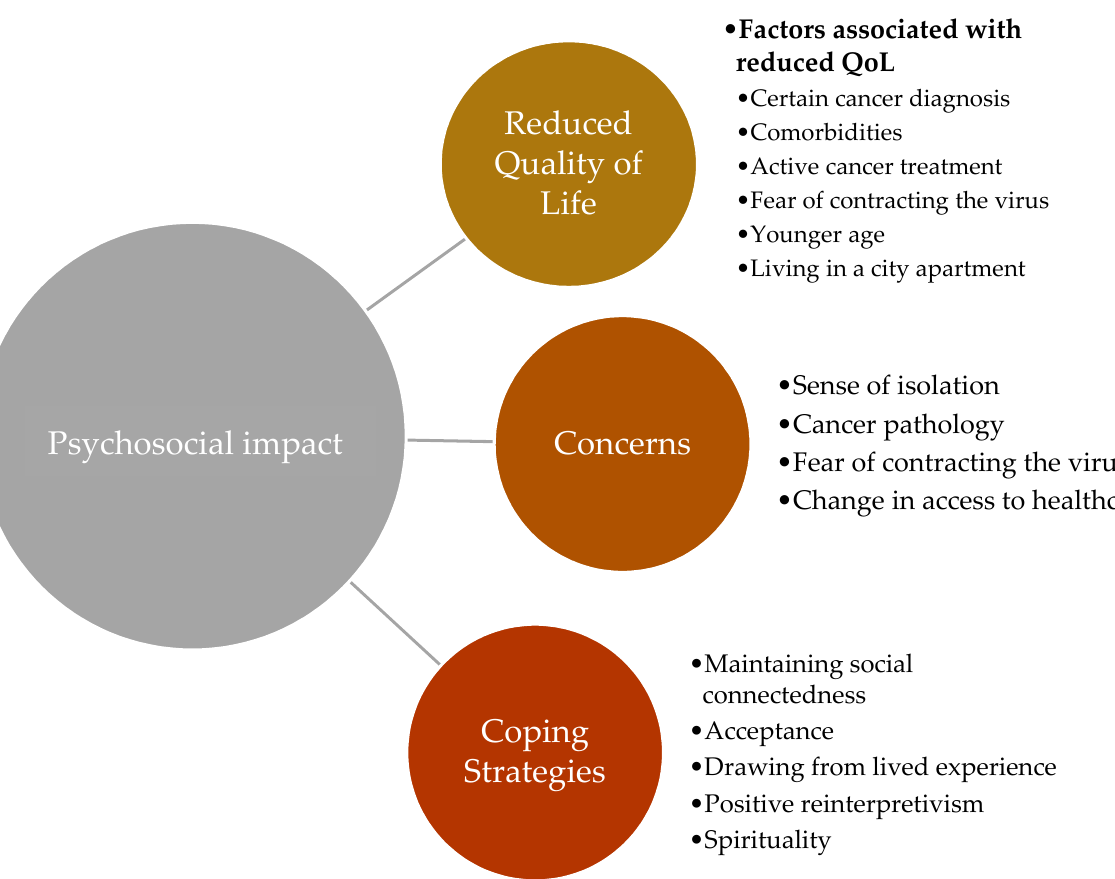
Figure 2. Psychosocial Impact of COVID-19 among older adults with cancer.